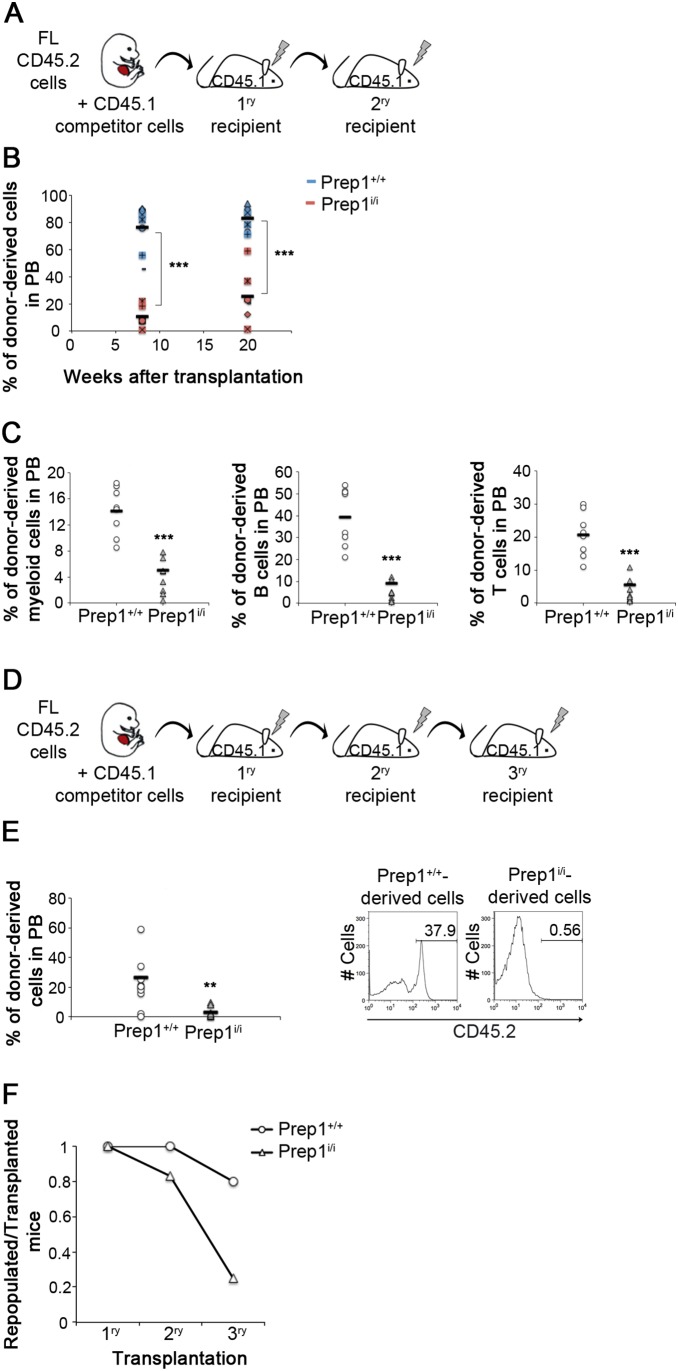
Prep1i/i HSCs undergo exhaustion faster than wt in serial transplantation assay.(A) 2×106 unfractionated BM cells from primary recipients were injected into secondary hosts. Primary recipients had received 1×106 unfractionated CD45.2+ FL cells together with 1×106 unfractionated CD45.1+ wt BM cells (chimerism shown in FigureS4). (B) PB analyses of secondary recipients were performed 8 and 20 weeks after transplantation to detect CD45.2+ cells. Each recipient is depicted with a separate symbol, blue and red colors indicating Prep1+/+ and Prep1i/i reconstituted mice, respectively. Black bars represent the mean values in Prep1+/+ or Prep1i/i reconstituted mice (n = 8 for each genotype at both time points; p-value<0.001 at both time points). (C) 20 weeks after transplantation, PB of secondary hosts was analysed for donor-derived myeloid cells (CD45.2+Gr1+Mac1+; p = 0.000017), B lymphoid cells (CD45.2+B220+; p = 0.000007) and T lymphoid cells (CD45.2+CD3+; p = 0.000017). Black bars represent mean values (n = 8 for each genotype). (D) Tertiary transplantations were performed injecting 2×106 BM cells from secondary recipients into tertiary hosts. (E) PB of tertiary hosts was analyzed 20 weeks after transplantation to detect CD45.2+ cells. Black bars represent the mean values (n = 10 for Prep1+/+ and n = 8 for Prep1i/i; p-value = 0.007). On the right, representative FACS histograms obtained for CD45.2+ cells of control and mutant tertiary recipients. (F) The ratio between the number of positively repopulated mice (CD45.2+ cells >2%) and transplanted mice is represented for primary, secondary and tertiary transplantations for both genotypes (primary transplantation n = 10 for each genotype; secondary transplantation n = 8 for each genotype; tertiary transplantation n = 10 for Prep1+/+ and n = 8 for Prep1i/i).